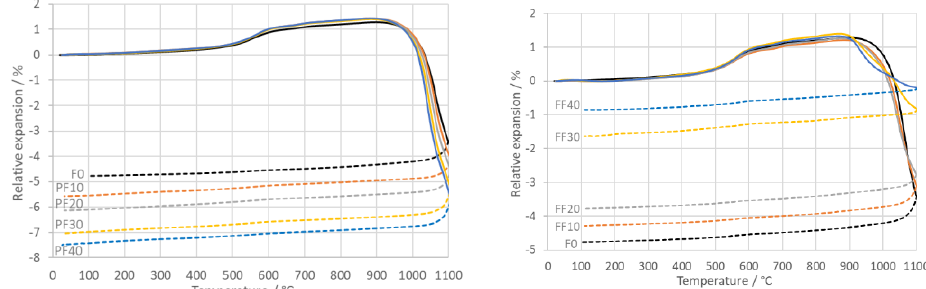
Figure 4. The thermal expansion of PF ( left ) and FF ( right ) samples (dashed lines correspond to the cooling stage of the firing). Figure 5. Total relative shrinkage of PF ( left ) and FF ( right ) samples (measured at the room temperature after firing at 1100 °C).